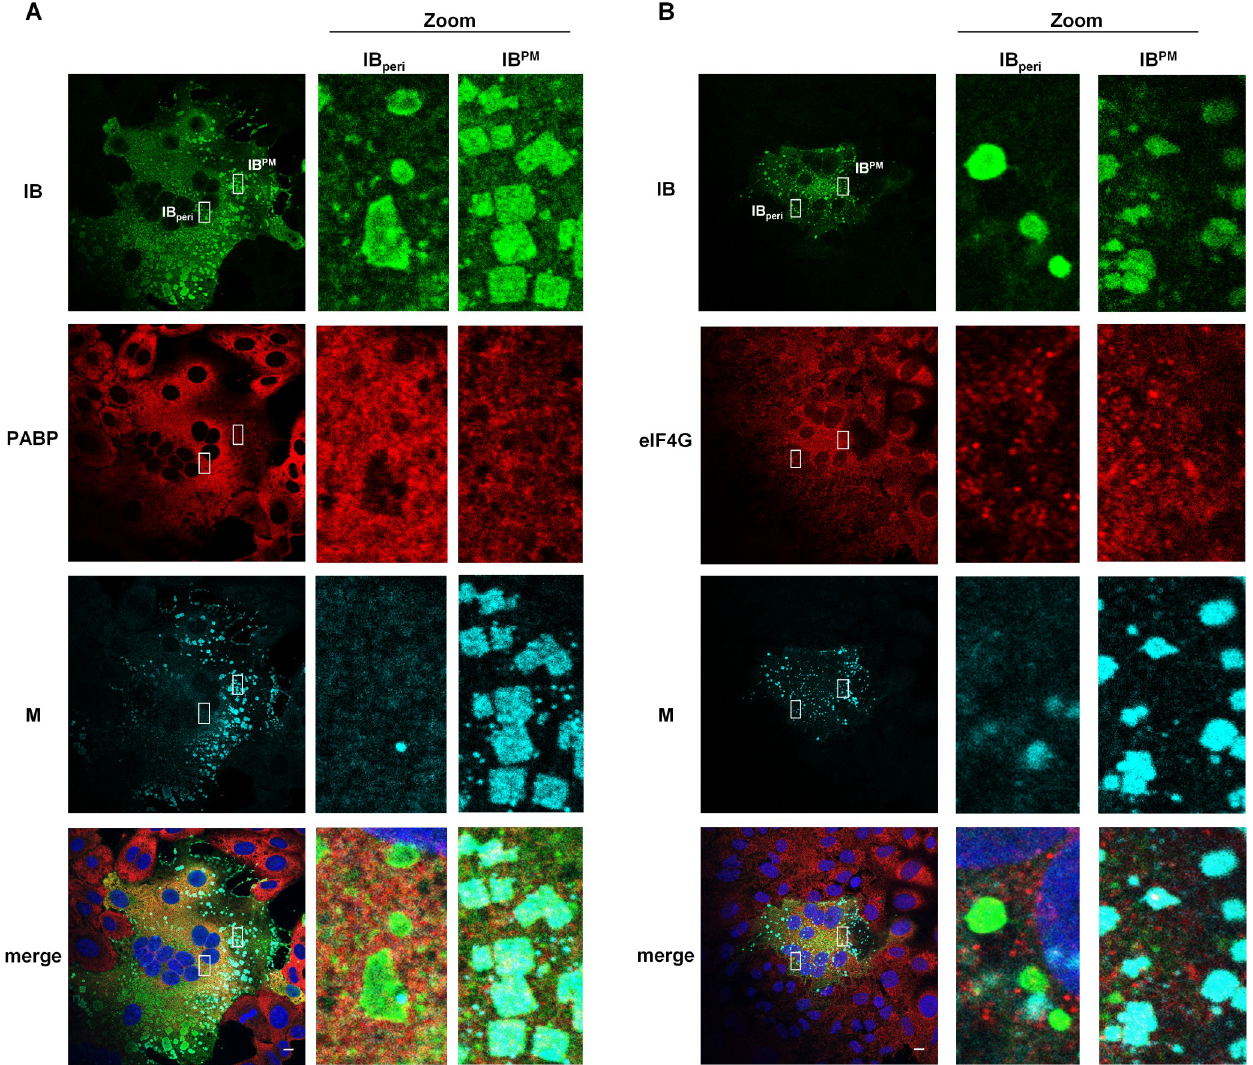
Fig 5. Colocalization of NiV IBs with mRNA binding proteins. Vero76 cells were infected with NiV at a MOI of 0.05. 18.5 h p.i. cells were fixed with 4% PFA for 48 h and permeabilized with methanol/acetone. (A) NiV IBs were visualized by using NiV N-specific antibodies (green) and Zenon-labeled anti-M peptide serum (cyan). mRNA (red) was detected with an antibody directed against the PolyA binding protein (PABP). (B) NiV IBs (green) and NiV M (cyan) were costained with an anti-eIF4G antibody (red). Nuclei were counterstained with DAPI (blue). In the zoom panels of the confocal images, enlarged views of IB peri and IB PM in the boxed regions are shown. Scale bars, 10 μ